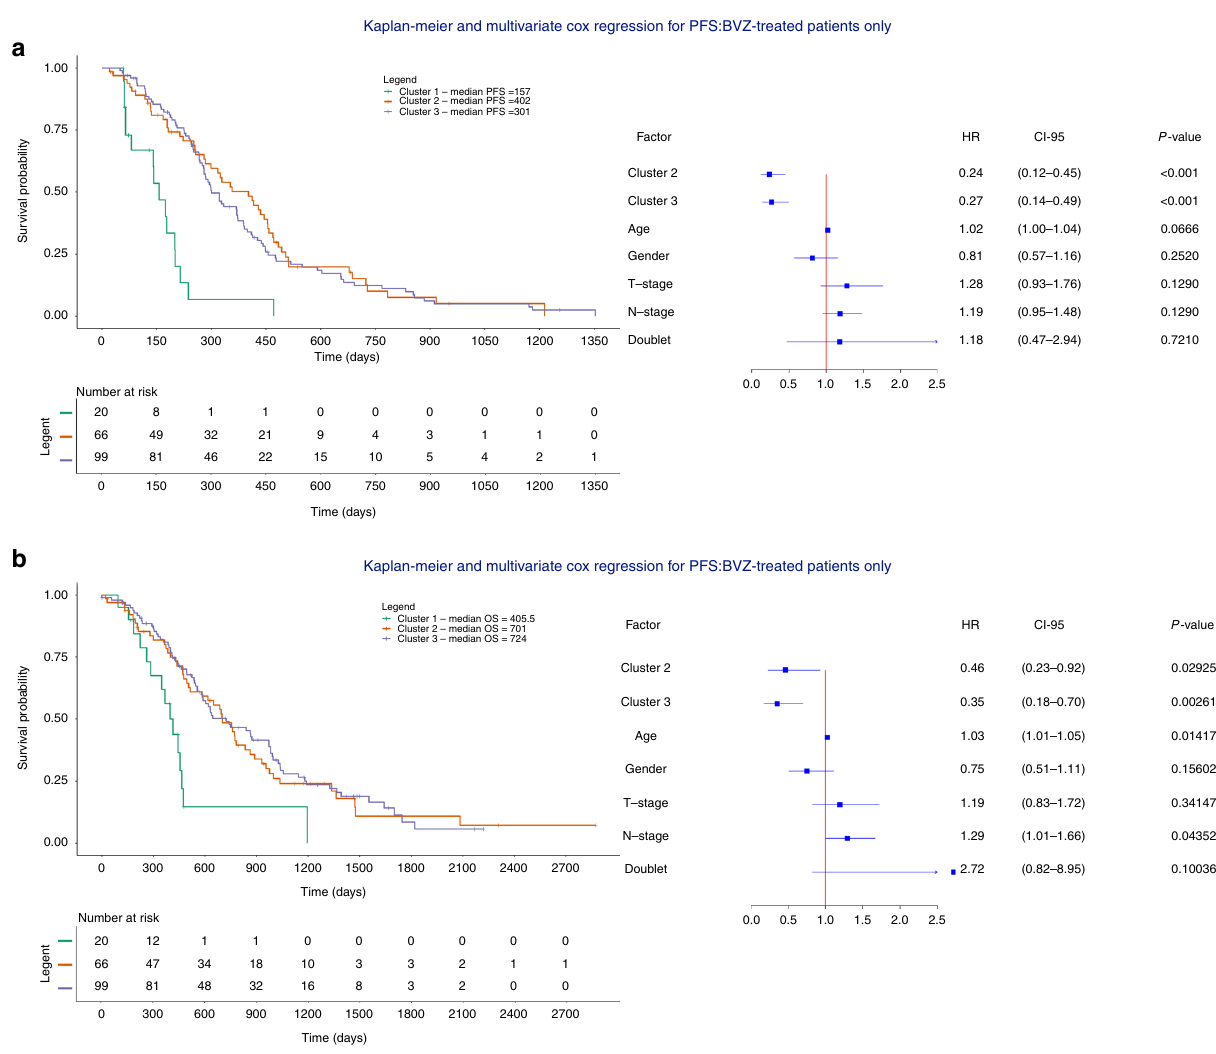
Fig. 3 Multivariate Cox regression of the different clusters BVZ-treated mCRC samples. a , b Kaplan-Meier plots and multivariate Cox regression with hazard ratios, 95% con fi dence intervals and P -values for CNA clusters are shown while correcting for the relevant covariates in mCRC samples treated with chemotherapy + BVZ ( n = 185). Cluster 1 is considered a reference. Doublet stands for mono-chemotherapy (FP) or a combination of chemotherapy (FP-OX, FP-IRI). Clusters 2 and 3 are correlated with signi fi cantly better PFS ( a ) and OS ( b ) independent of clinical covariates. Doublet chemotherapy is not signi fi cant in either of the two respectively 149 and 85 days compared to chemotherapy alone. Similar results were obtained when combining patients from clusters 2 and 3 into one group ( P = 2.49 × 10 − 3 , HR = 0.68, CI 0.53 – 0.87, Cox regression) (Fig. 4d). Power calculations compar- ing tumors from cluster 1 versus cluster 2 and 3 for chemotherapy ± BVZ revealed 92% power to detect a HR = 0.68. Likewise, BVZ combination therapy showed improved OS for patients with tumors belonging to clusters 2 and 3 (Supplementary Figure 10).